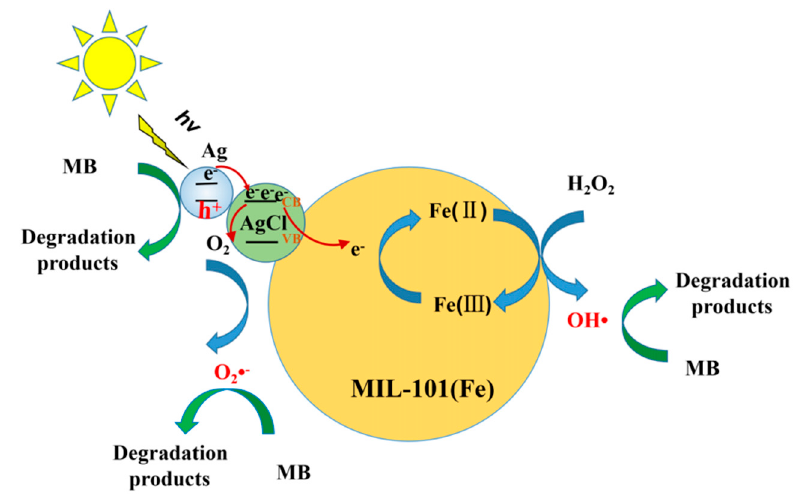
Figure 17. The proposed mechanism for the photo ‐ Fenton degradation of MB using Ag/AgCl/MIL ‐ 101(Fe) as catalyst.